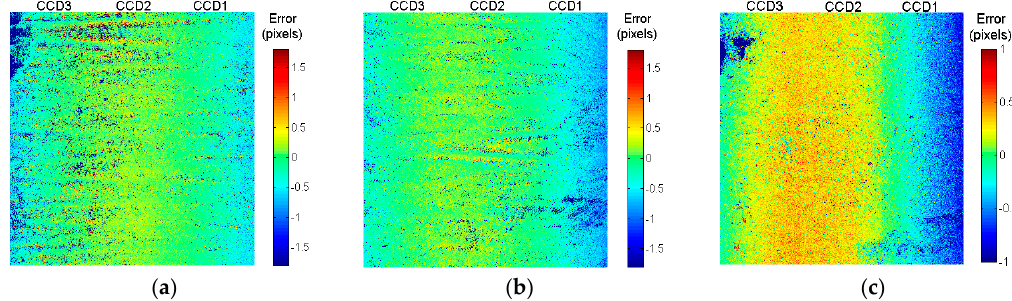
Figure 4. Parallax images between B1 and B2 across the track of ( a ) Scene A, ( b ) Scene B, and ( c ) Scene C.